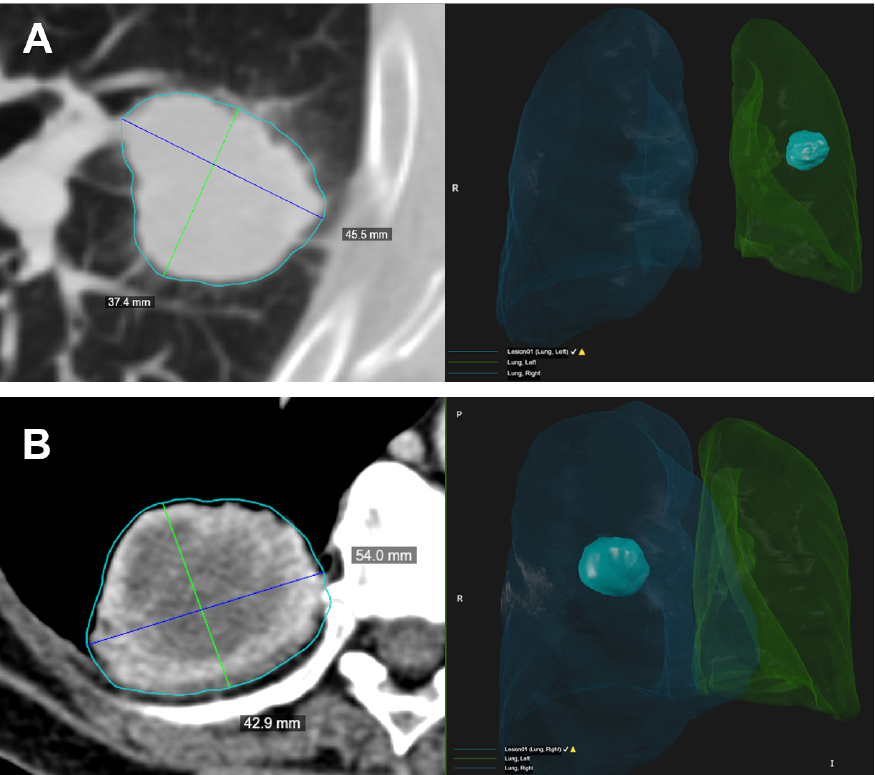
Figure 2. Two examples ( A , B ) of the semi-automated identification of the target lesion. On the left, the CT image with the lesion segmentation (light blue contour) and the longest diameters measured on the lesion volume. The blue lines represent the longest long axes and the green lines represent the longest short axes on the axial direction. On the right, it is possible to observe the 3D rendering of the lesion volume and its location inside the automatic lung segmentation.